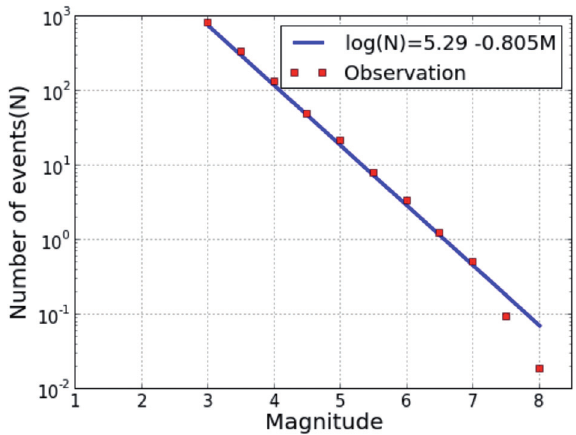
Figure 11. Gutenberg–Richter model (blue) for the EMCA cata- logue considering MLH